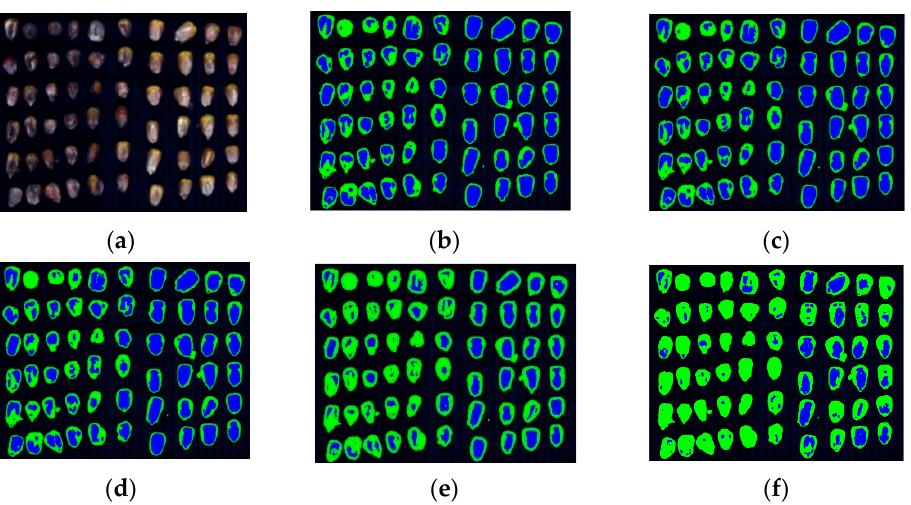
Figure 10. Clustering results in corn kernel mildew hyperspectral image data by different algorithms (spectral features). ( a ), Mildew corn kernels; ( b ), K ‐ means; ( c ), FCM; ( d ), KFCM; ( e ), GMM; ( f ), FCM ‐ SC. Table 1. Performance of different clustering algorithms on hyperspectral data (spectral